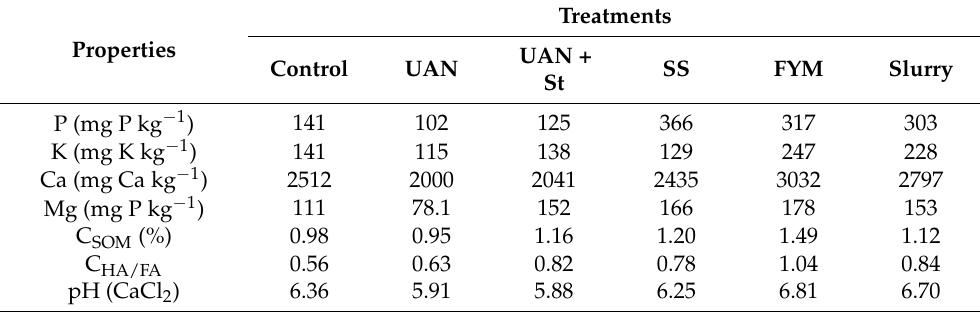
Table 2. Content of Mehlich 3 extractable nutrients (P, K, Ca, and Mg) and other soil properties in 2019,